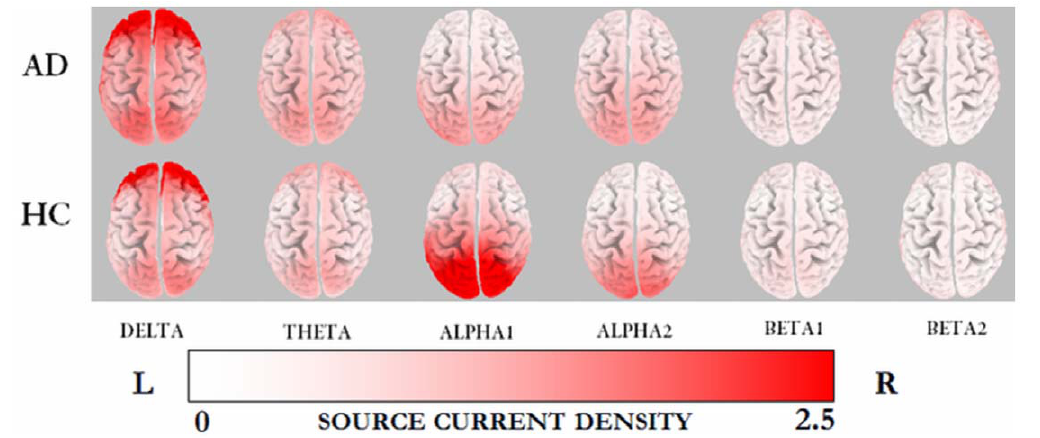
Figure 1. Averaged eLORETA solutions (current density at cortical voxels) of EEG sources for each frequency band in patients and controls. AD, Alzheimer’s disease; HC, healthy controls; L, left; R, right.